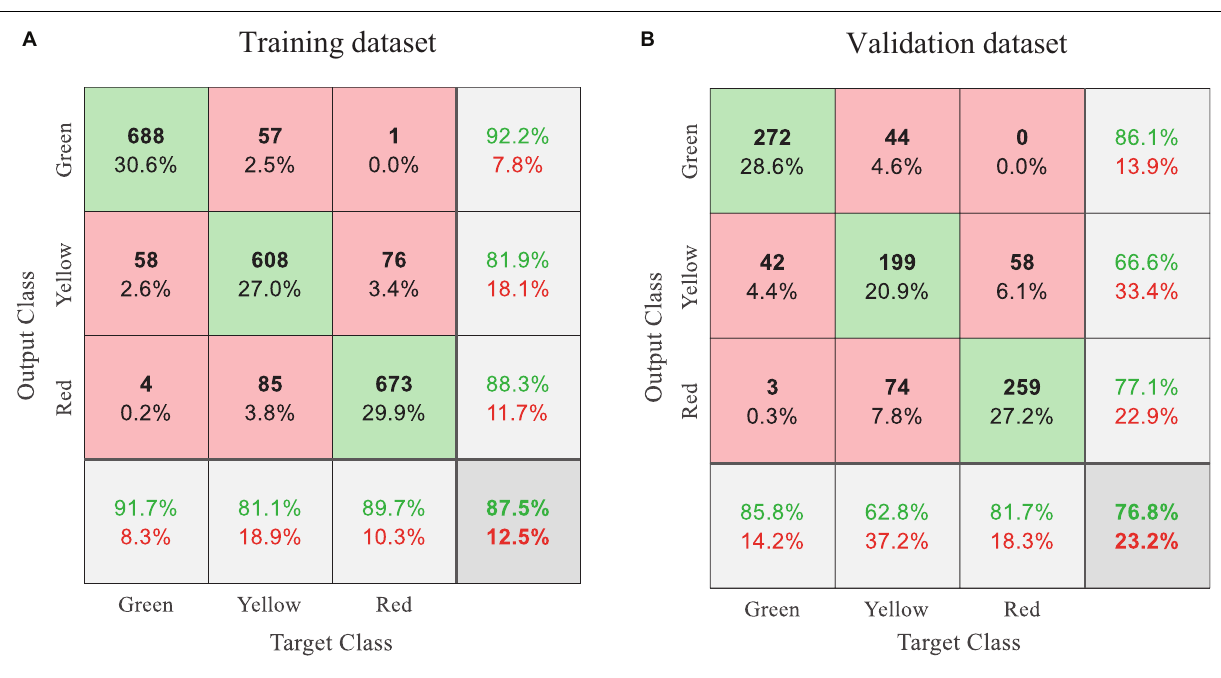
Frontiers in Built Environment |